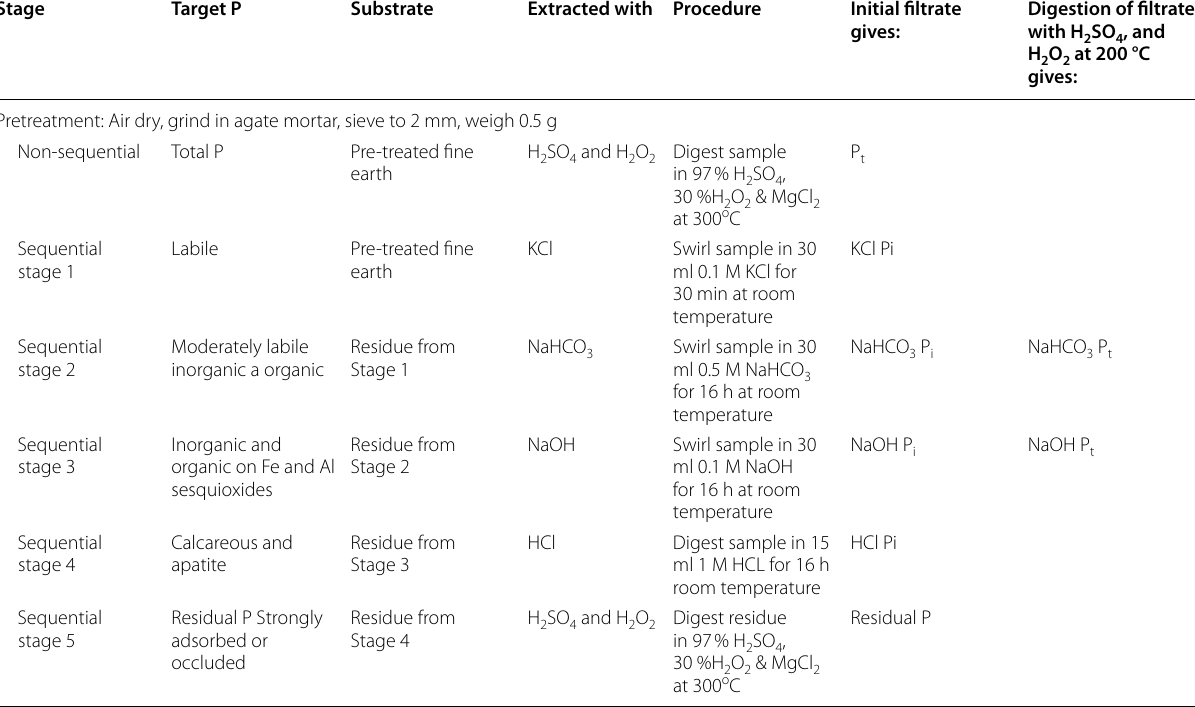
Table 1 P fractionation in soils of Green Island